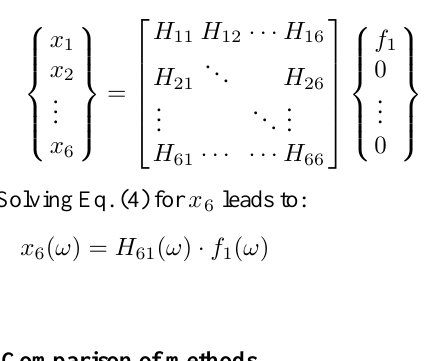
Fig. 1. (a) Model with source M 1 present; (b) model without source M 1